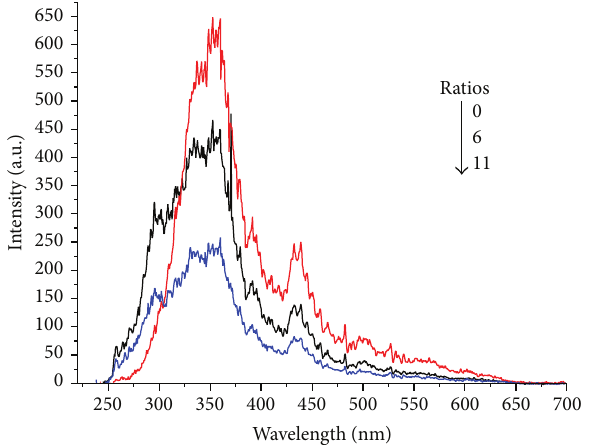
Figure 4: The effect of combination ratios on the resonance light scattering spectra of acidic subunit.